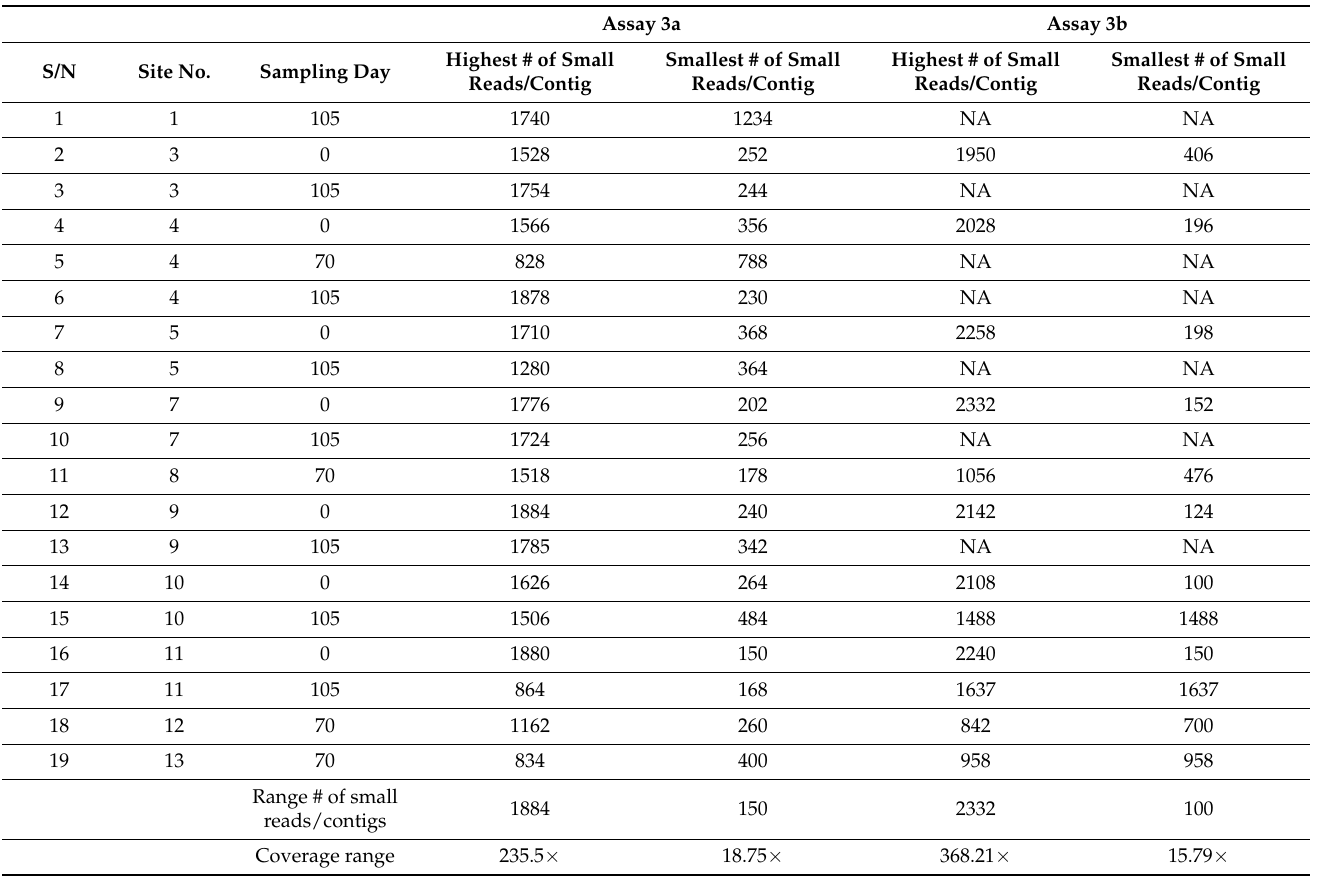
Table 3. Range of number of small reads that mapped to each of the EV LRISW contigs in Table 2 (and Table S1)—EV long-read contigs (column 6) and the corresponding range of contig coverage. Please note that the S/N column was added for clarity only, to show the number of samples (a serial count of 1–19) from which reads were recovered using LRISW (see Section 3.2.2) (i.e., there are 19 samples ST1-d105 to ST13-d70 from which reads were recovered). Hence, all data described here are for the LRISW. # means Number. Assay 3a Assay 3b S/N Site